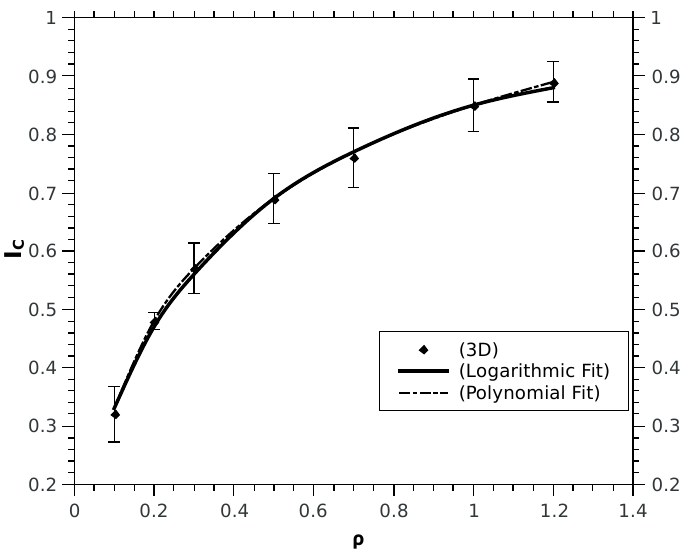
Figure 3. Computed values of I C [ ρ ( r )] for different densities in 3D obtained at optimal γ values. The analytic fit obtained in this case, I C [ ρ ( r )] = 0.847 + 0.241ln ρ ( r ) and the polynomial fit is given by I C = − 0.594 ρ ( 2/3 ) ( r ) + 1.838 ρ ( 1/3 ) ( r ) − 0.394 with RMS values 0.0273 and 0.0324 respectively. All values are in atomic